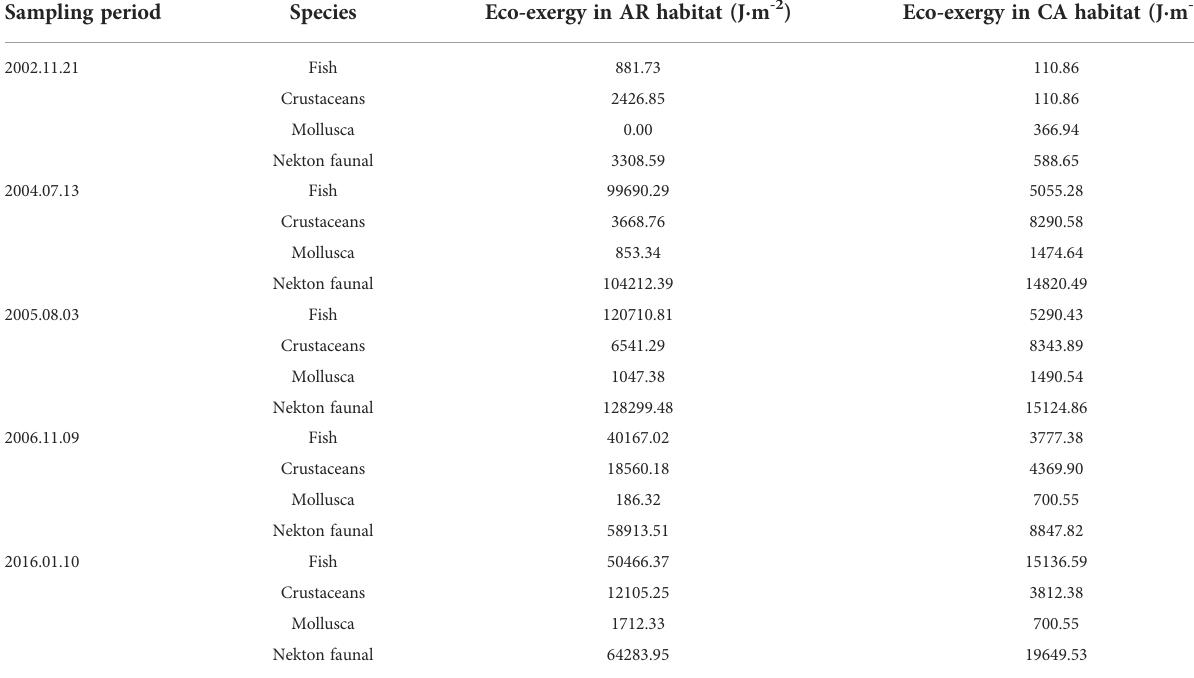
TABLE 7 Eco-exergy of the nekton community in two habitats survey during trawl net sampling period. Sampling